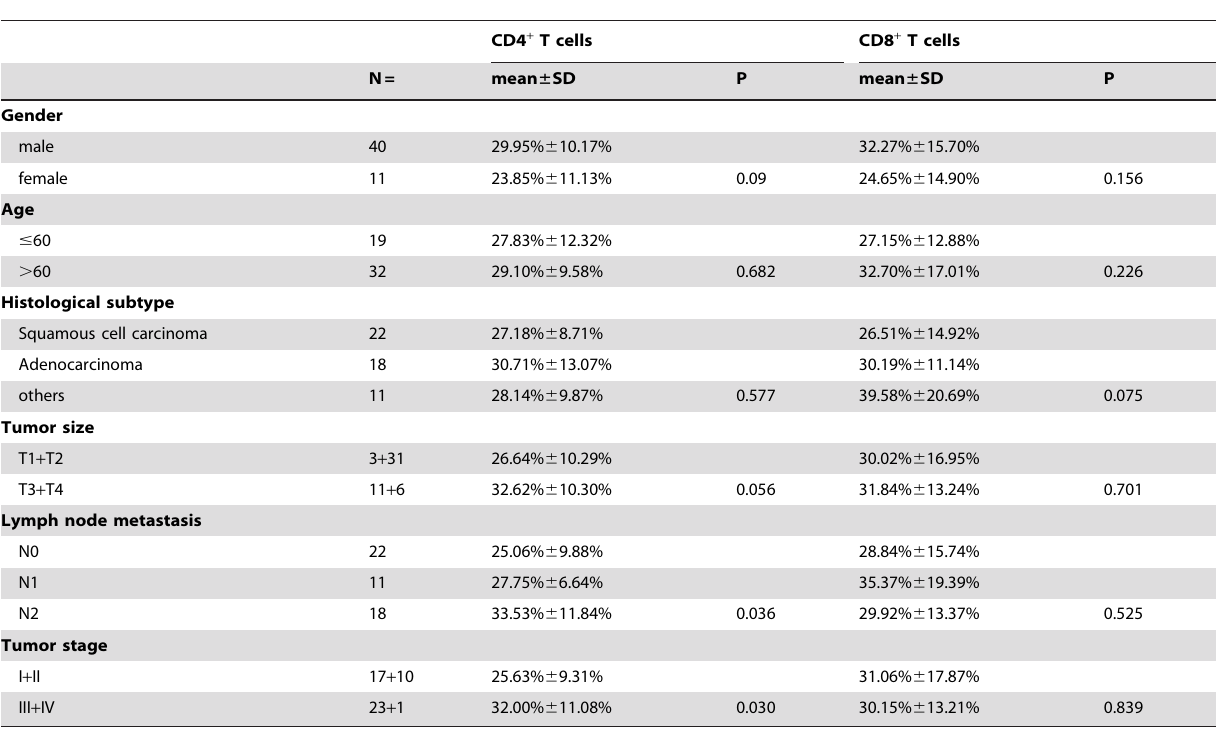
Table 2. Clinical significance of Tim-3 + TILs in patients with